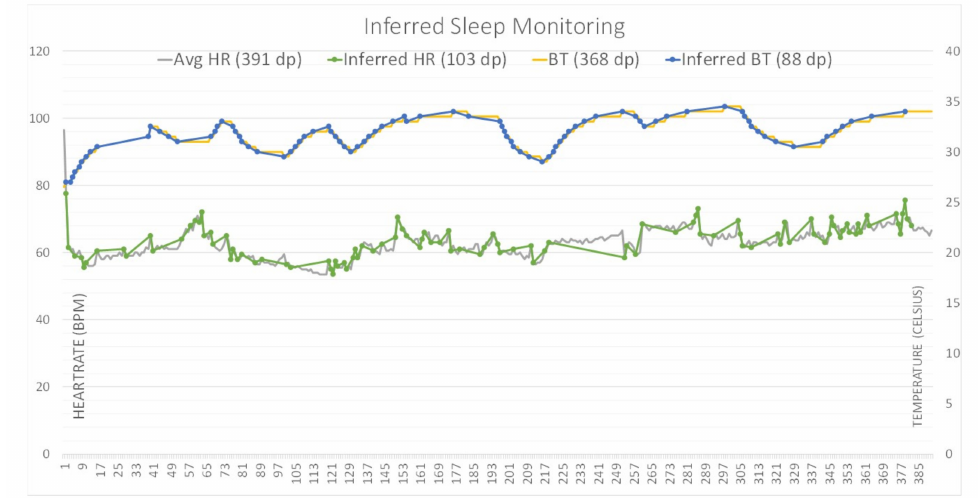
Figure 3. Inferred heart rate (HR) and body temperature (BT) of sleep monitoring data (based on sampled by minutes)– inferred BT data represents the original well whilst inferred HR data shows relatively more gaps (this could be improved by using beacon data